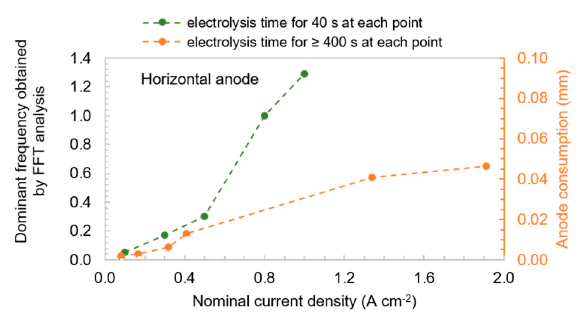
Figure 15. Dominant frequency obtained from FFT spectrum for the horizontal anode. Data for electrolysis time of 40 s are obtained from Stanic et al. [17].